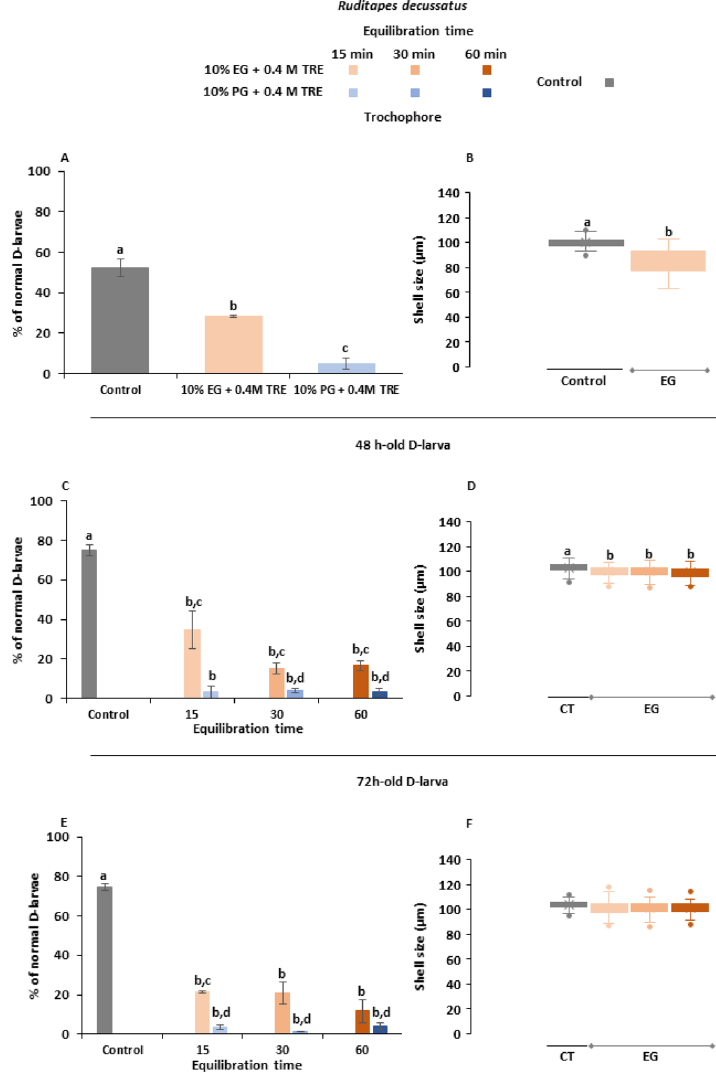
Figure 5. Post-thaw fitness parameters on larvae of Ruditapes decussatus cryopreserved at trochophores, 48 and 72 h-old D-larval stages: (A) survival of cryopreserved trochophores; (B) shell size of developed D-larvae from cryopreserved trochophores; (C) survival of cryopreserved 48 h-old D-larvae; (D) shell size of developed D-larvae from cryopreserved 48 h-old D-larvae; (E) survival of cryopreserved 72 h-old D-larvae; (D) shell size of developed D-larvae from cryopreserved 72 h-old D-larvae. Larvae were cryopreserved using two CPA solutions: 10% ethylene–glycol (EG) + 0.4 M trehalose (TRE) and 10% prophylene–glycol (PG) + 0.4 M TRE (final concentrations), both prepared in filtered sea water (FSW). Increasing equilibrium times were tested on D-larvae. Results are expressed as mean normal D-larval percentage ± standard deviation, SD (n = 100, 3 replicates per treatment) or as box plots for shell size assessments (µm) considering mean value (Mean ± Standard Deviation, SD) (n = 35, 3 replicates per treatment). Different letters show statistical differences with p ˂